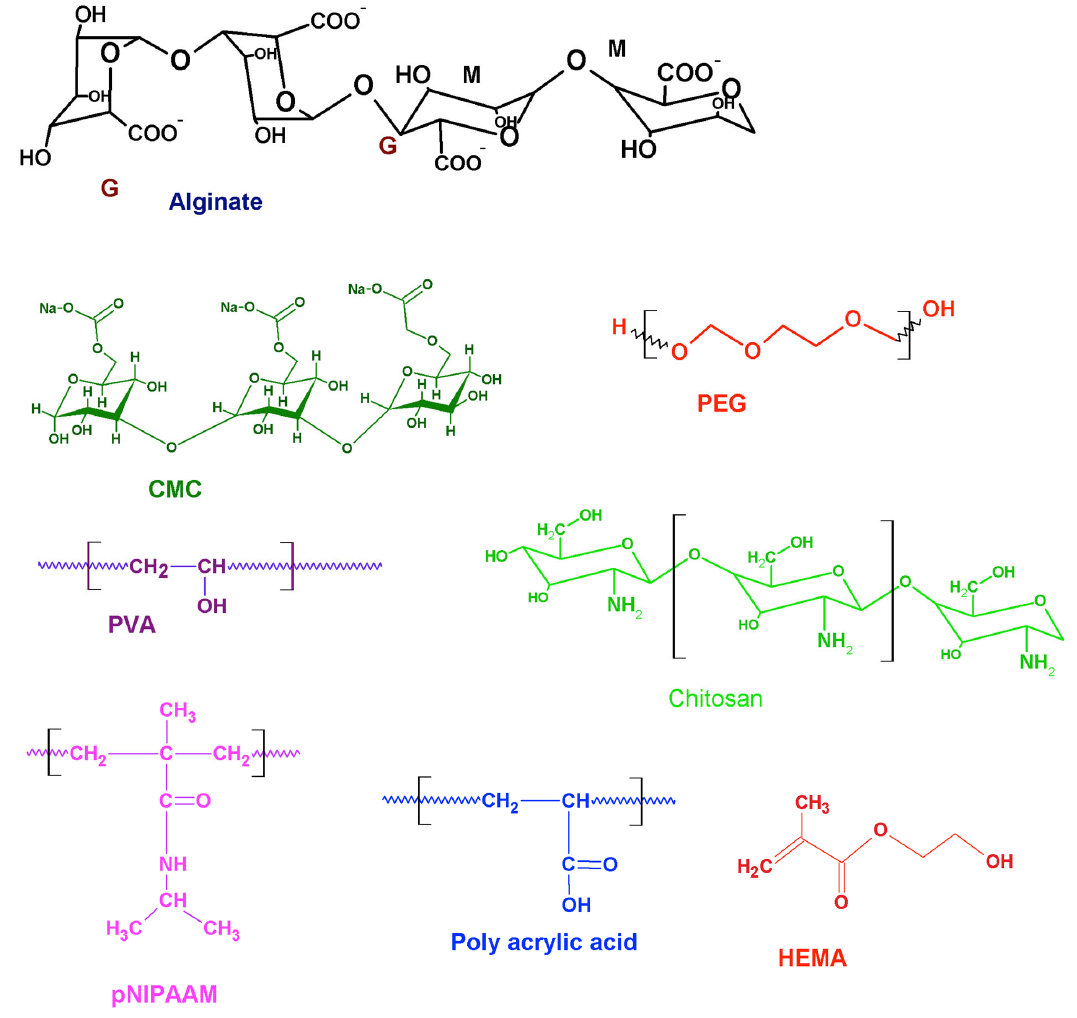
Figure 2. Commonly used polymers for fabricating intelligent hydrogels.